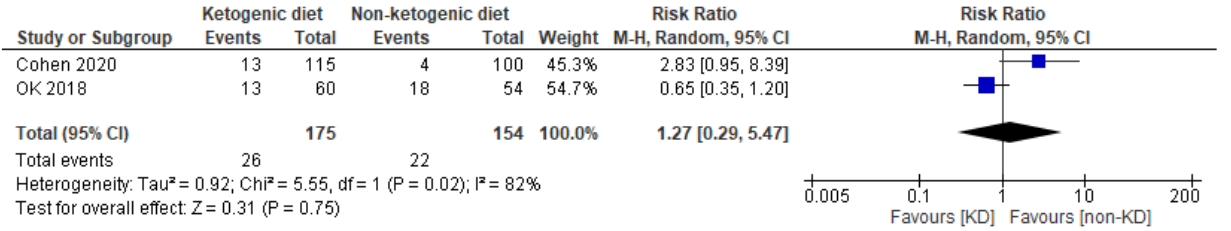
Figure 5. Forest plot of risk ratio in random effects model for adverse events in comparison of KD and non ‐ KD group.